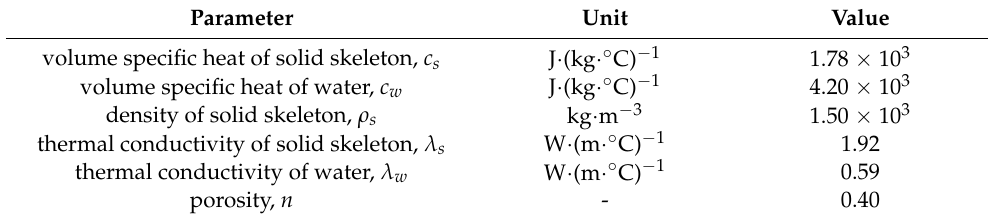
Table 1. List of aquifer parameters. Parameter volume specific heat of solid skeleton, c